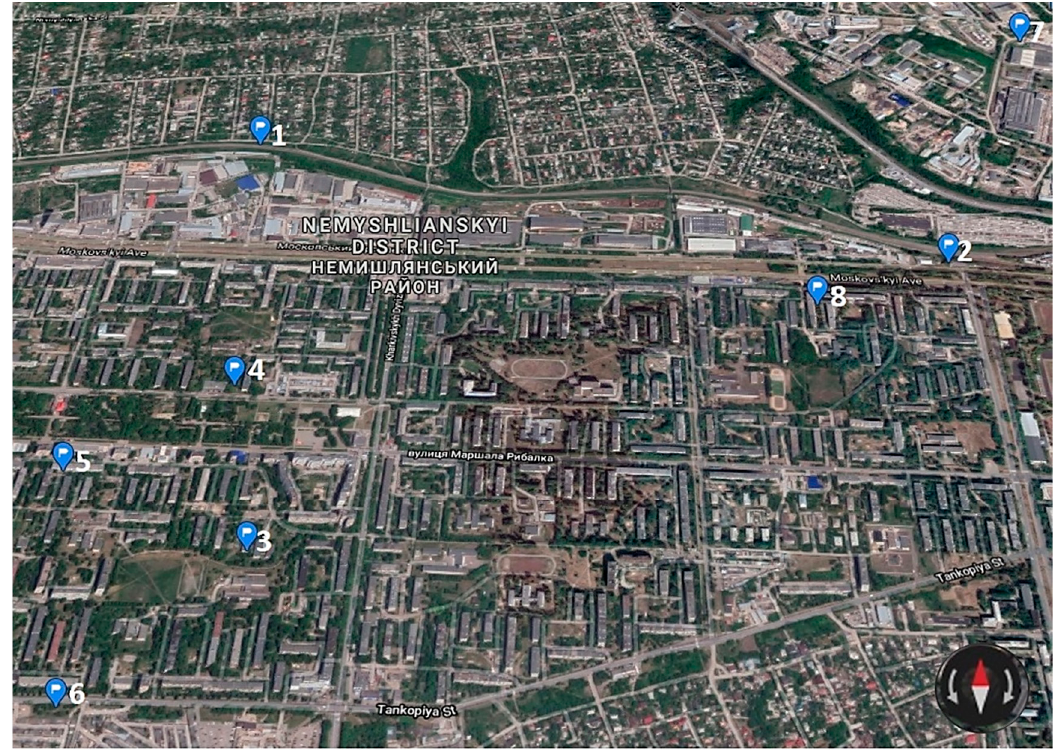
Figure 2. Sampling sites (Ukraine, Kharkiv city, Nemyshlianskyi district). 1—private sector, 2 and 6—transport area, 3—school, 4—square park, 5 and 8—household plots of multi-story apartment buildings, 7—industrial cluster (maps from open sources Google).